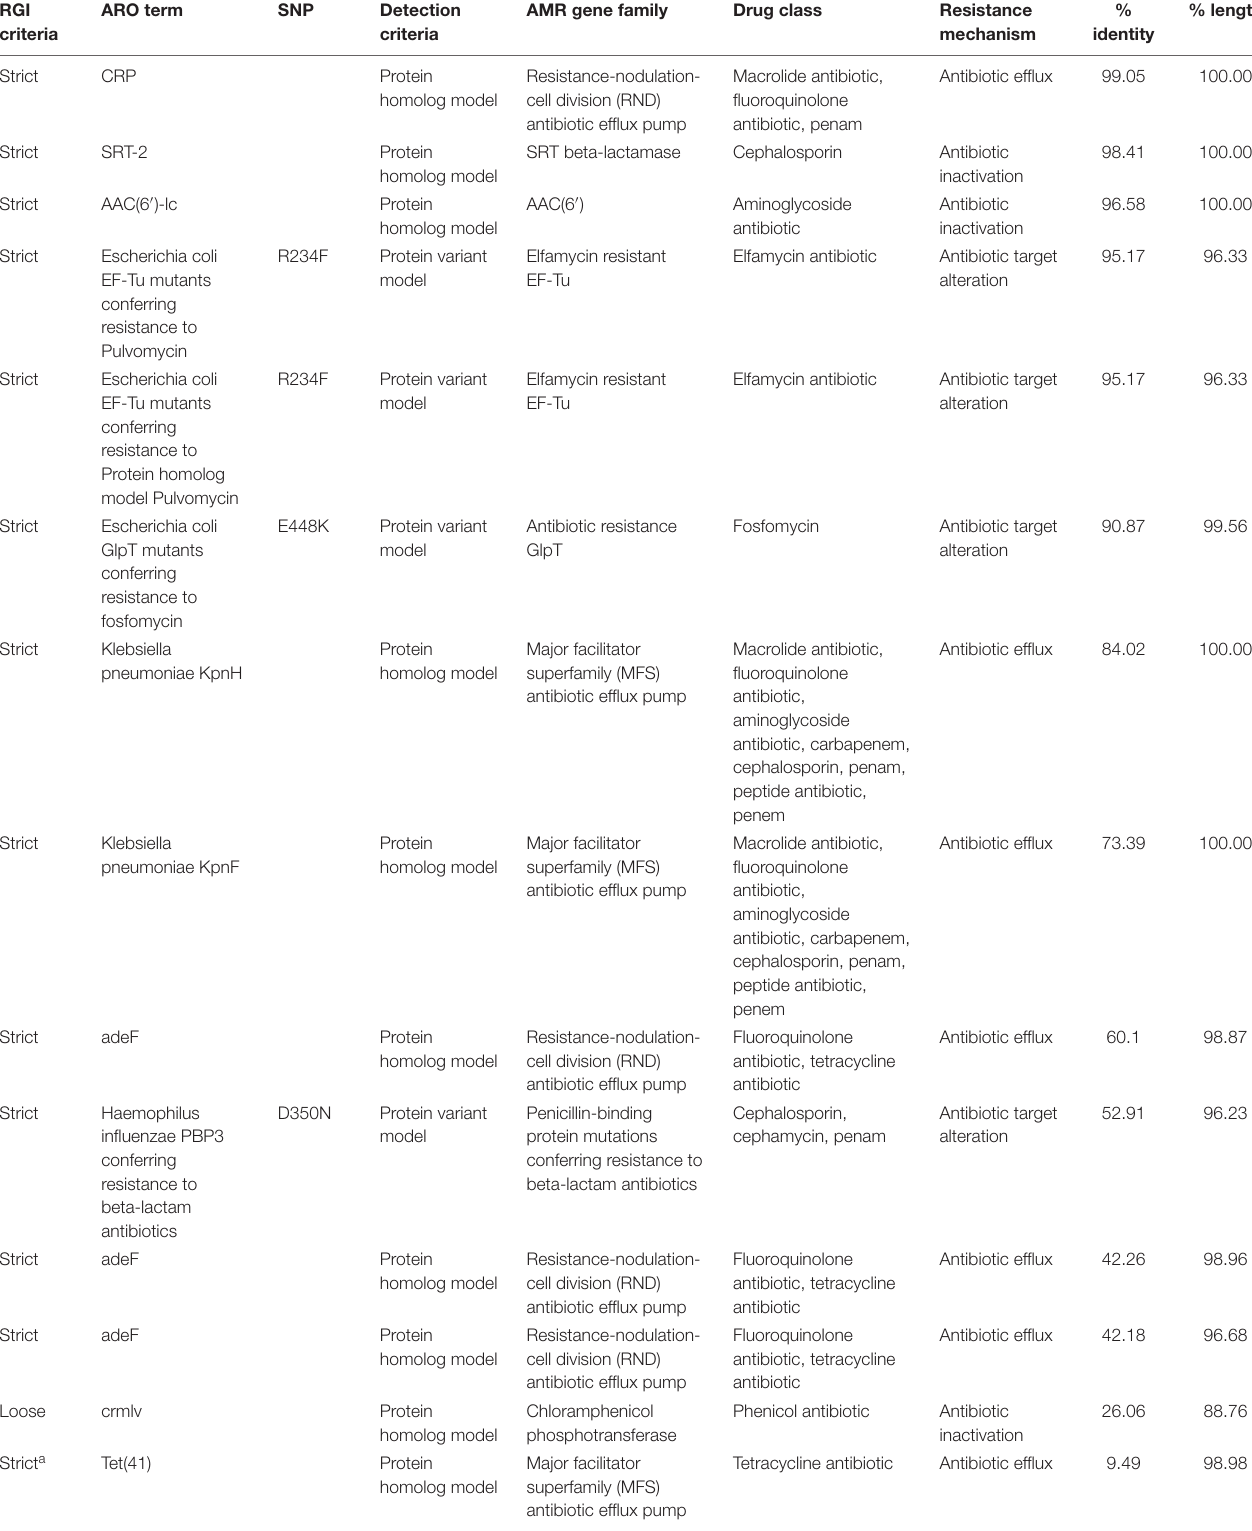
TABLE 2 | Resistance gene identifier hits shared between CBS11 and CBS12 detected as “strict” and hits of pAM01 plasmid detected as